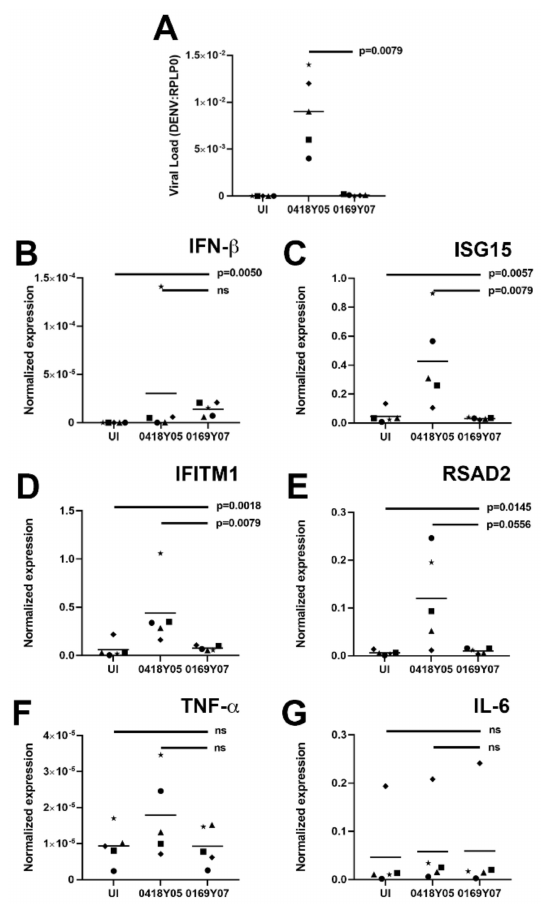
Figure 3. Interaction of primary human retinal pigment epithelial cells with DENV-1 strains: DENV-1 viral strains = Singapore National Environmental Agency Isolate (EHI)0418Y05 (isolated during 2005 epidemic) and EHI0169Y07 (isolated during 2007 epidemic); n = 5 primary human retinal pigment ep- ithelial cell isolates; multiplicity of infection = 10; inoculation interval = 90 min; time of infection = 48 h. ( A ) Graph showing viral load expressed as DENV transcript relative to ribosomal protein lateral stalk subunit P0 (RPLP0). ( B – G ) Graphs showing cellular expression of transcript relative to RPLP0: IFN- β = interferon- β , IFITM1 = IFN-induced transmembrane protein 1, RSAD2 = radical SAM domain- containing 2, ISG15 = IFN-stimulated gene 15, TNF- α = tumor necrosis factor- α , IL-6 = interleukin-6. Shapes represent individual cell isolates, and crossbars represent means. Statistical comparisons were made across three groups by Kruskal–Wallis test and across two groups by Mann–Whitney U